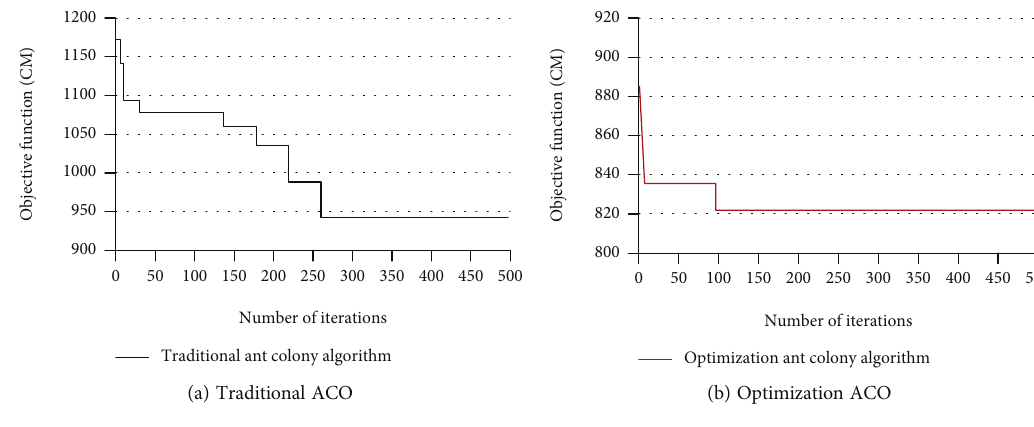
Figure 6: Iterative objective results of traditional ACO and optimized ACO. Table 2: Genetic algorithm and parameters of simulation welding robot. Genetic algorithm